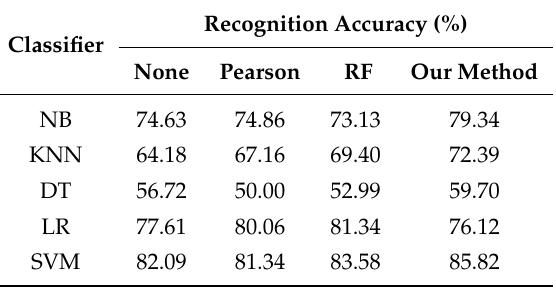
Table 8. Average recognition accuracy of speaker-dependent speech emotion recognition on